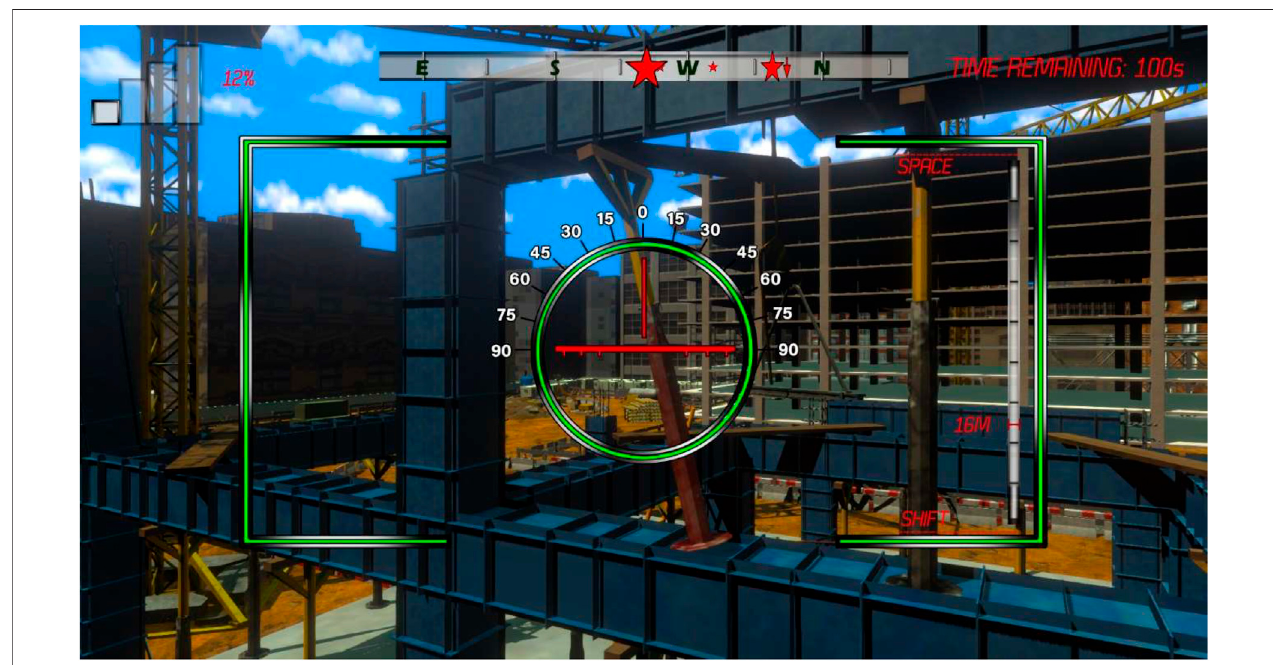
FIGURE13 | Screenshot of game showing using the compass at the top ofscreenwiththe star symbolon itto locate ahazard which has changed the drone view fi nder to green.